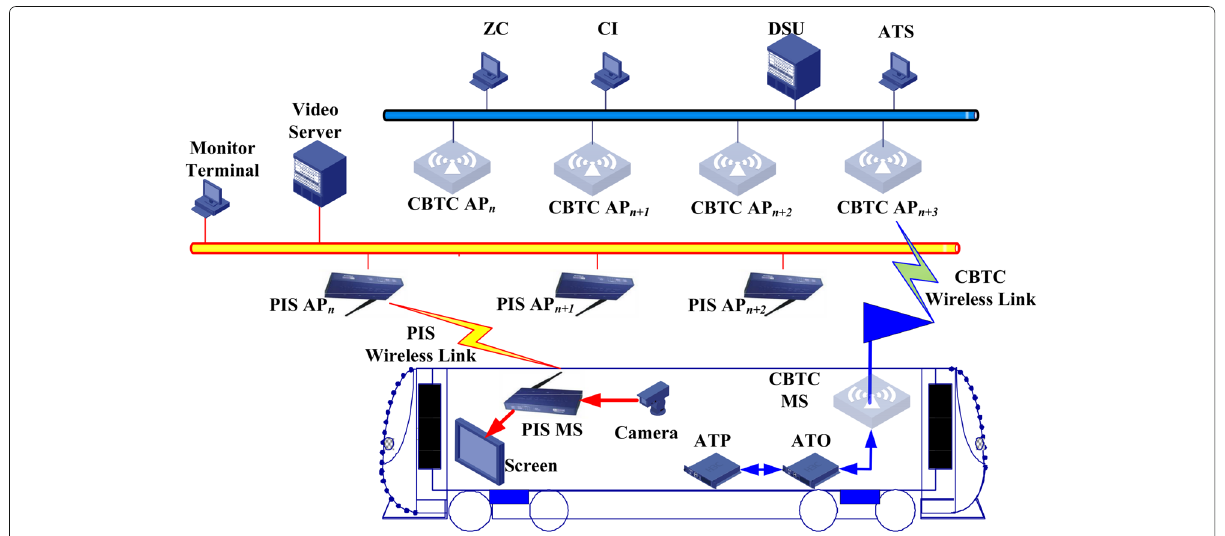
Fig. 1 Coexistence of a CBTC system and a PIS